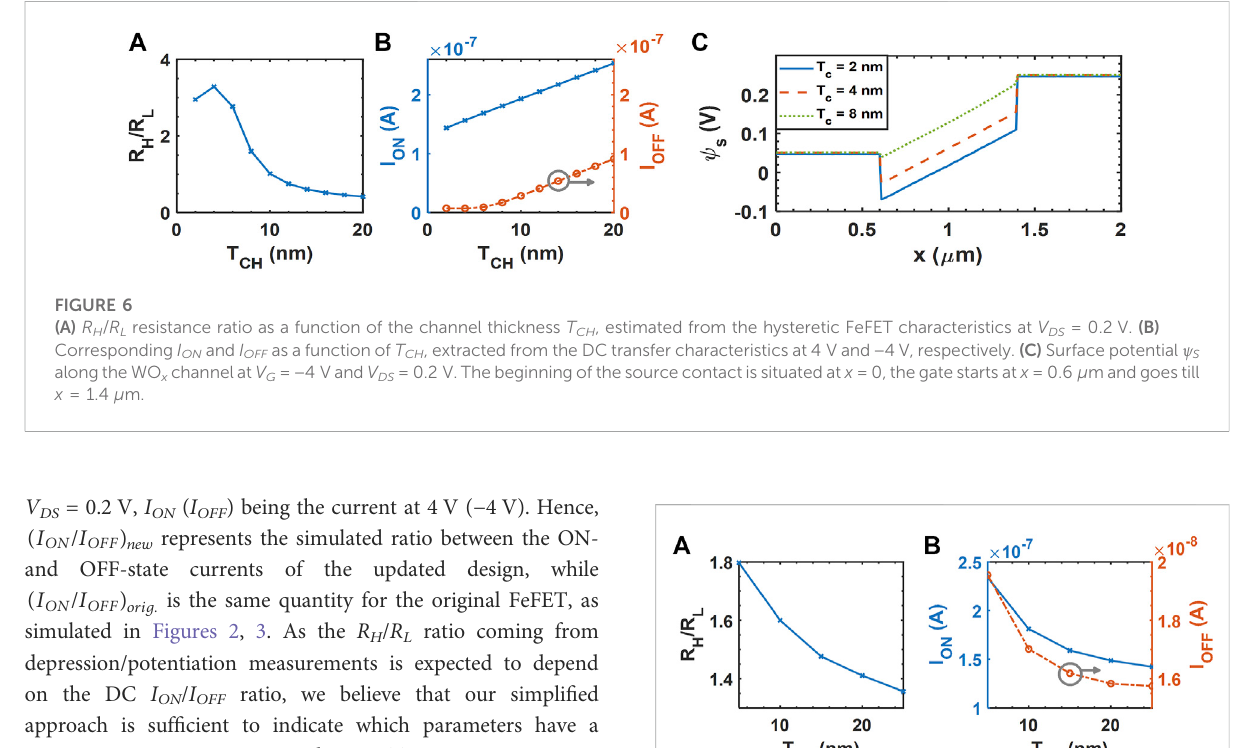
FIGURE 7 (A) Simulated R H / R L resistance ratio as a function of the ferroelectric layer thickness T FE . (B) Corresponding I ON and I OFF currents as a function of T FE . All simulations were performed at V DS = 0.2